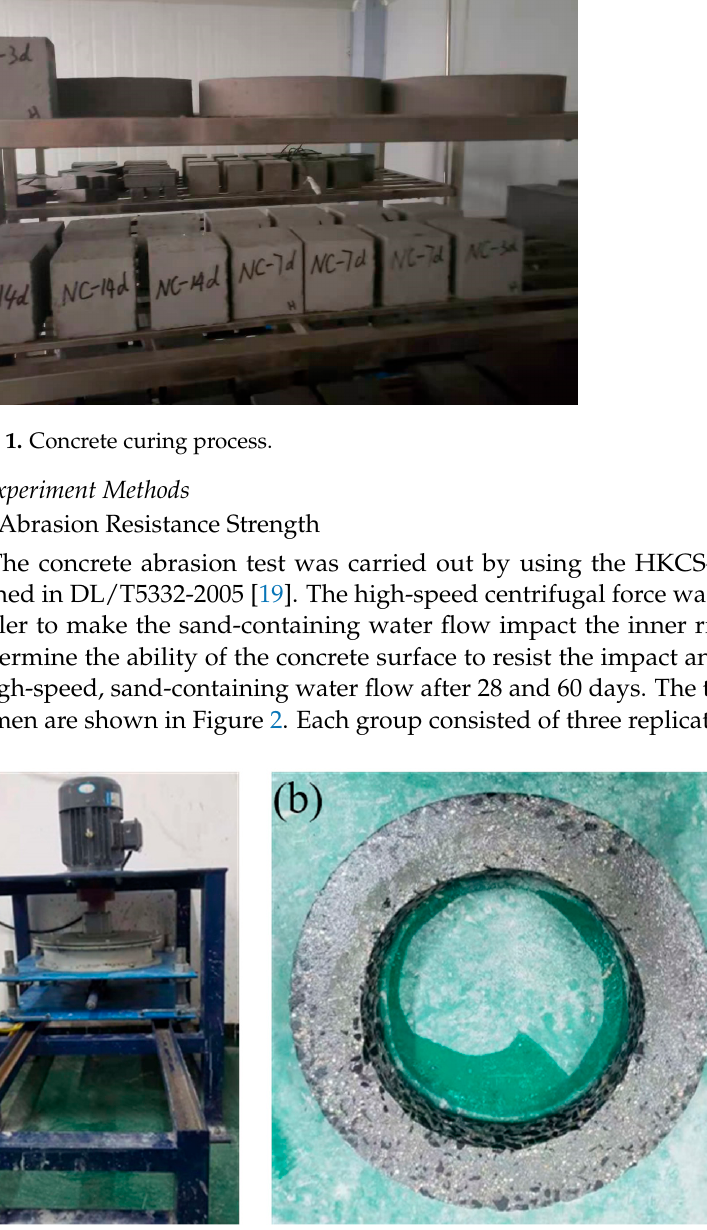
Figure 1. C oncrete curing process.